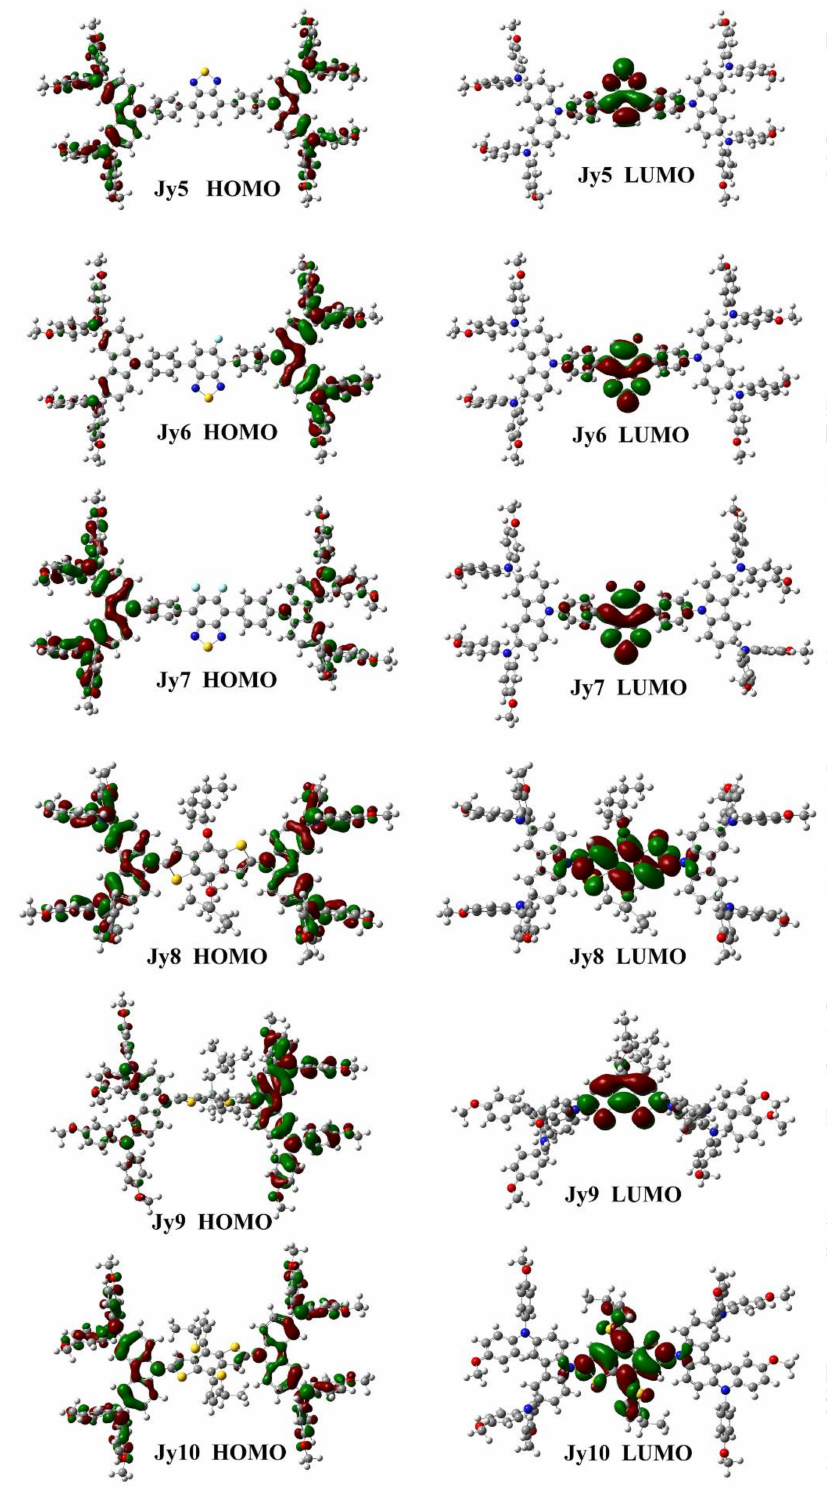
Figure 4. Frontier molecular orbital plots of the HOMO and LUMO for the studied molecules in solvent calculating by density functional theory